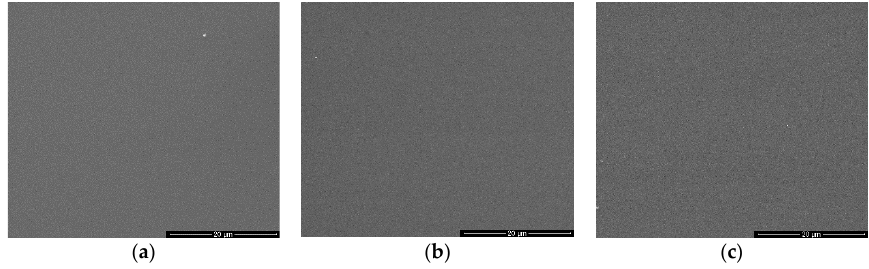
Figure 4. Top view Scanning Electron Microscopy (SEM) images of the magnetron sputtered PTFE materials upon injected RF power to the plasma source: ( a ) 50 W; ( b ) 80 W; and ( c ) 110 W.